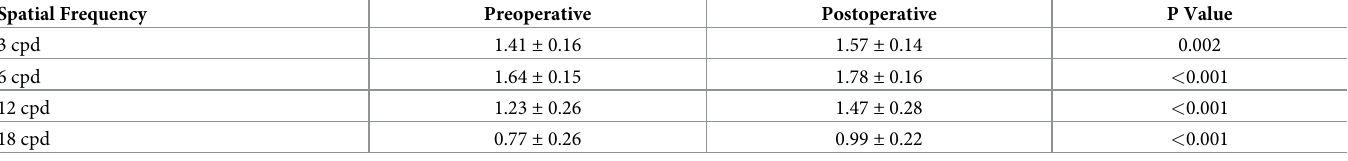
Table 3. Comparison of preoperative and postoperative the mean log contrast sensitivity. Spatial